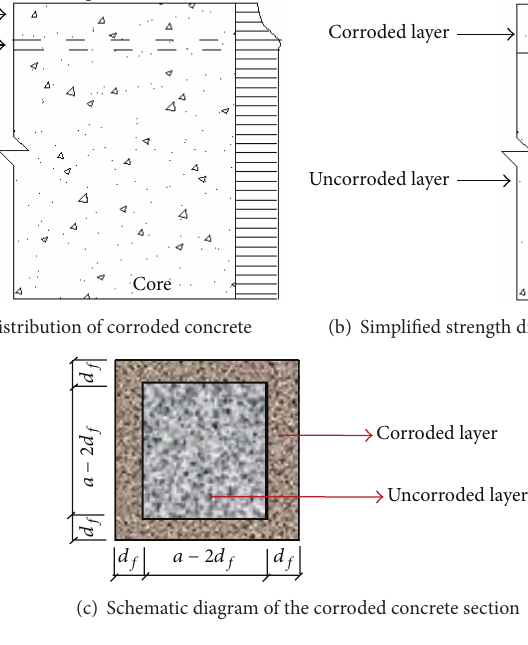
Figure 8: Simplified distribution of the strength of sulfate-corroded